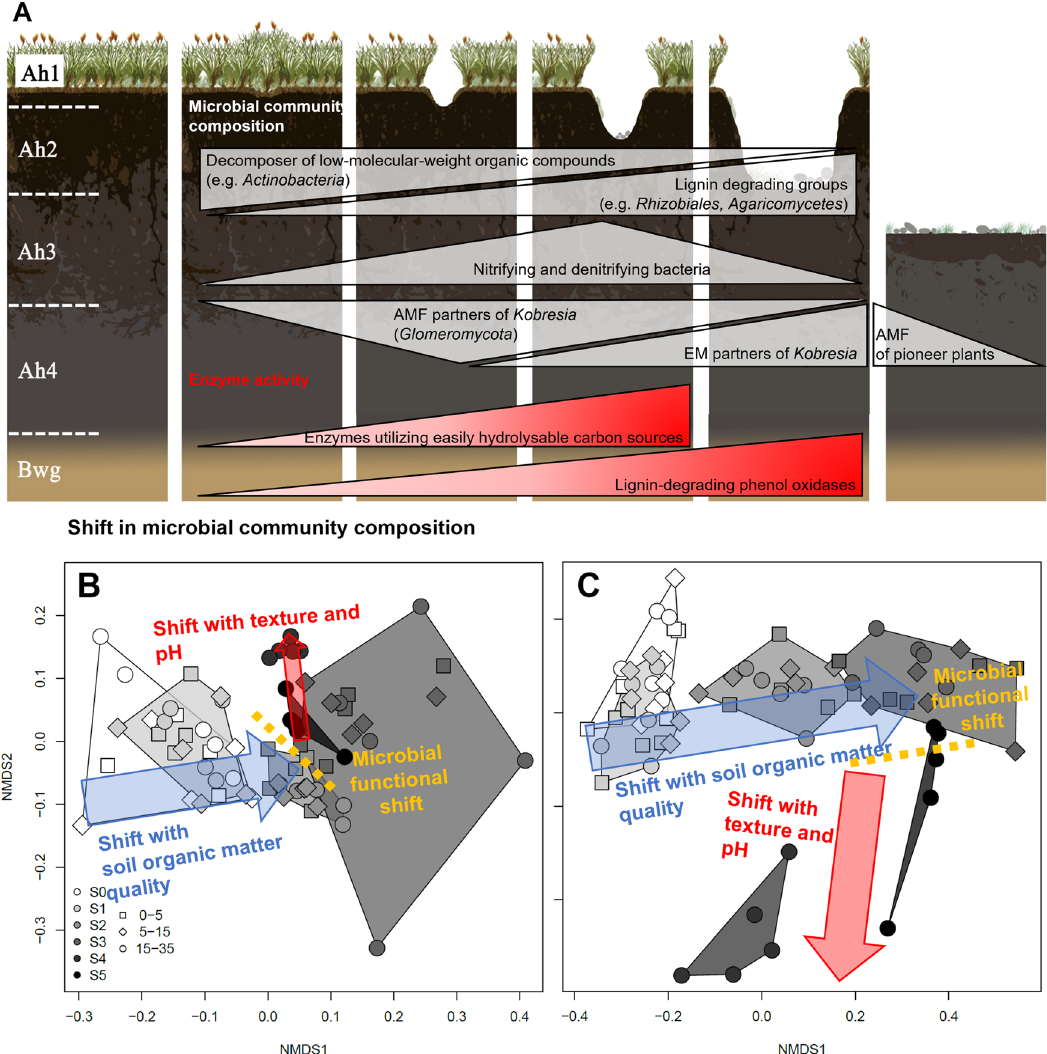
Fig. 3 Overview of generalized changes in microbial community composition and functioning along the degradation sequence from intact (S0) to severely degraded (S5) stage. Generalized changes in microbial community composition and enzyme activities ( A ). Simpli fi ed non-metric multidimensional scaling (NMDS) plots derived from terminal restriction fragment length polymorphism (t-RFLP) data for the bacterial ( B ) and fungal ( C ) communities. Shaded areas mark each degradation stage, symbols indicate soil depth, and arrows show most important driving factors (canonical correspondence analysis, p < 0.05). Individual variables underlying the processes described by the blue and red arrows are shown in Supplementary